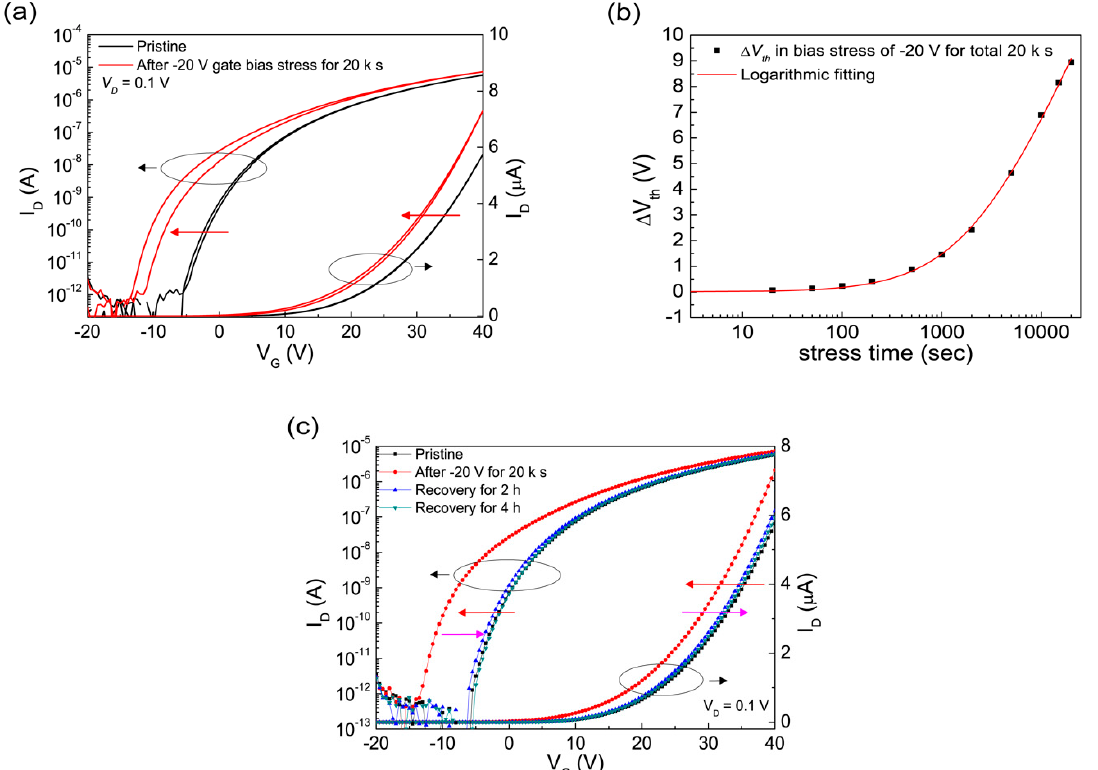
Figure 5. ( a ) The instability behaviours of transfer characteristics (log( I D ) – V G and I D – V G ) of the ZnO FETs (at V D = 0.1 V) under prolonged negative ( − 20 V) gate bias for 20 ks at R.T. The transfer curve shifts in parallel to negative direction. ( b ) V th sfhit as a function of stress time in negative bias stress (NBS) at R.T. ( c ) Recovery behaviour of ZnO FETs at R.T in ambient air after NBS.